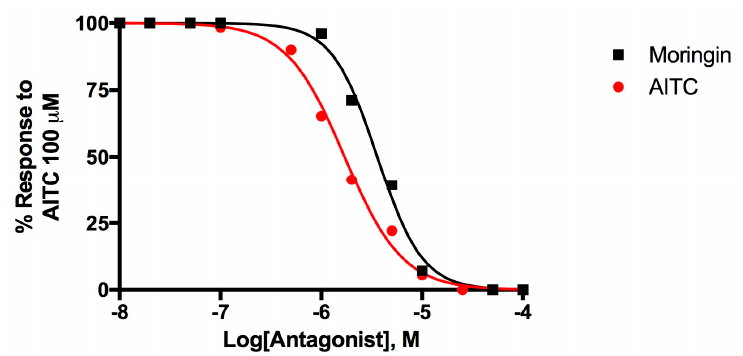
Figure 3. Dose-related e ff ect of 5-min pre-incubation of rTRPA1-HEK-293 cells with moringin and allylisothiocyanate (AITC) on the AITC (100 µ M)-induced elevation of intracellular Ca 2 + . Data are expressed as percentages of the e ff ect observed with AITC (100 µ M) alone.